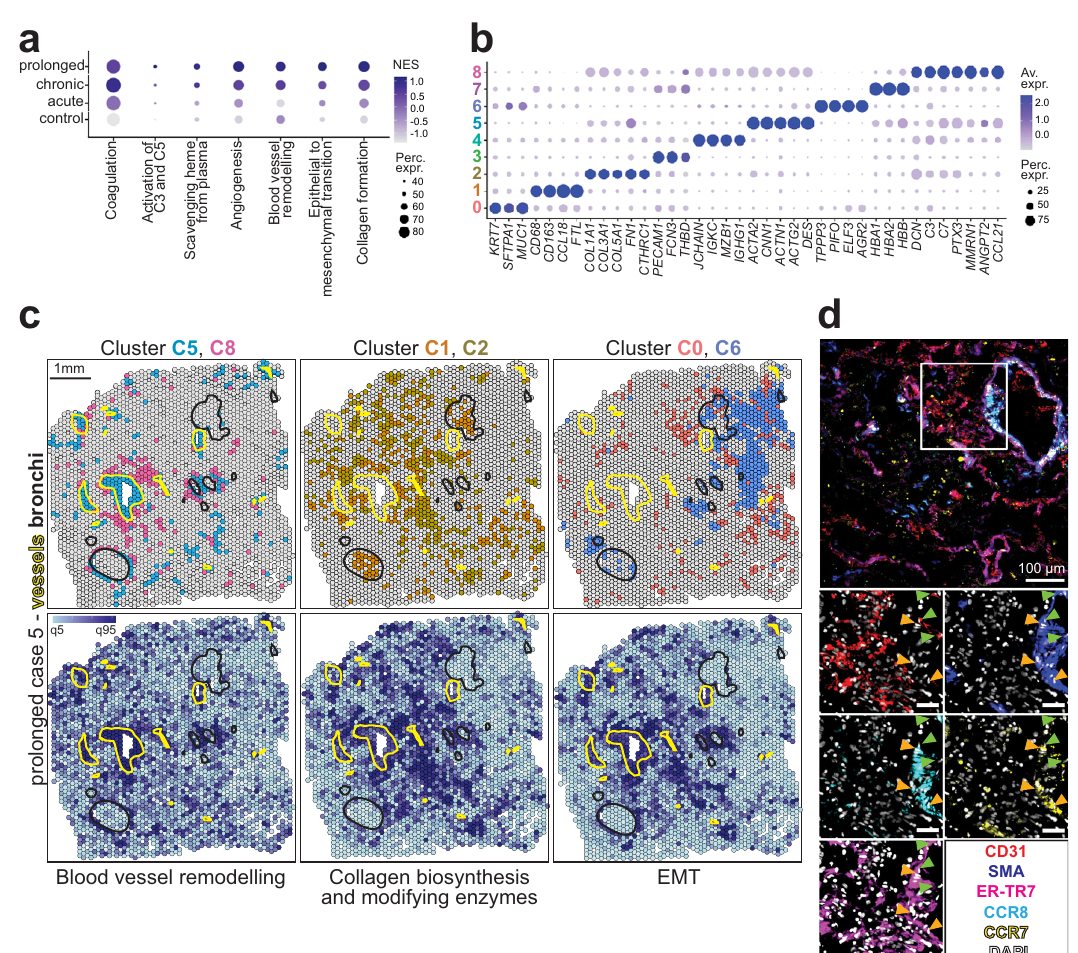
Fig. 3 | Activated lung adventitial niches are fi brotic foci in severe COVID-19. a Dotplotdepictingthenormalizedenrichmentscores(NES)andthepercentageof spots under tissue expressing relevant transcriptional pathways for each disease group, as analyzed by gene set enrichment analysis (GSEA) of spatial tran- scriptomics (ST) data. Coagulation, Angiogenesis and Epithelial to mesenchymal transition (Hallmark), Activation of C3 and C5, Scavenging of heme from plasma and Collagen biosynthesis and modifying enzymes (Reactome) and Blood vessel remodeling (GOBP) areshown ( n =12 tissue sections). b Dotplot depicting theNES and percentage of expression of several relevant transcripts among the top 25 differentially expressed genes (DEG) within each ST cluster, as shown in Supple- mentaryFig.3A – C. c Color-codedtissuespotsfromoneexemplarytissuesectionof a COVID-19 prolonged case analyzed by ST, depict the spatial distribution of